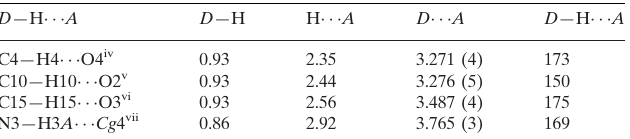
Hydrogen-bond geometry (A˚ , (cid:2)